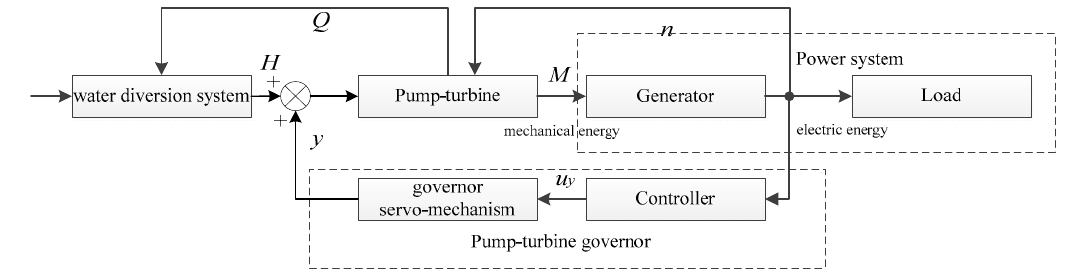
Figure 1. Structure of pumped storage unit governing system.